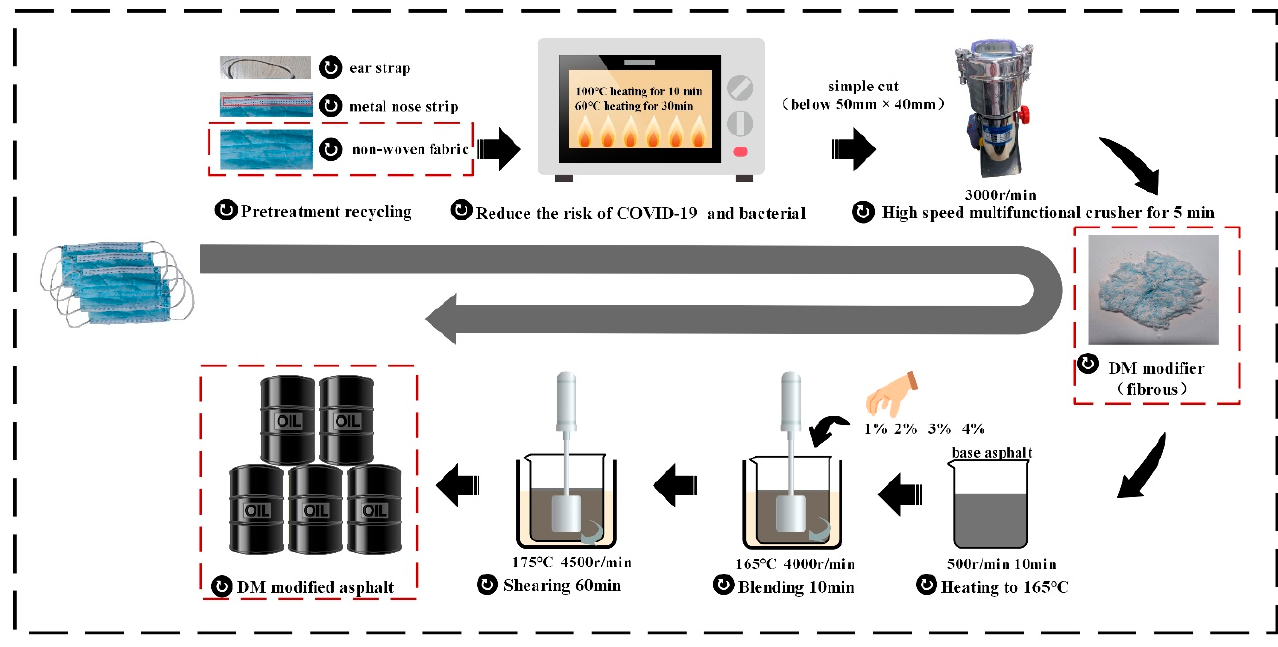
Figure 1. DM-modified asphalt preparation process.